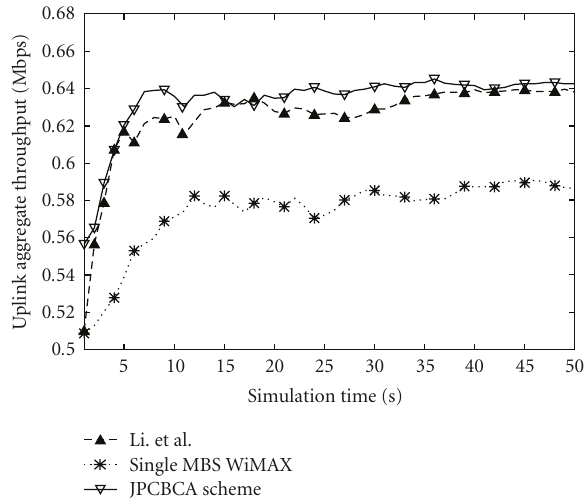
Figure 8: Uplink aggregate throughput. This figure shows that our Joint Power Control, Base Station Assignment, and Channel Assignment (JPCBCA) Scheme can achieve higher throughput as compared to the single MBS WiMAX network and the work by Li et al.